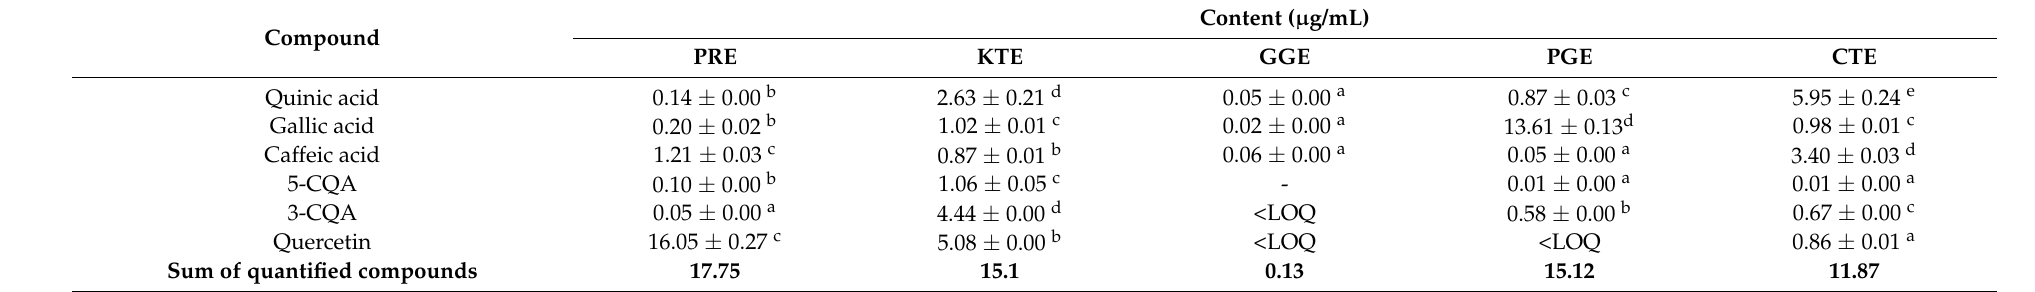
Table 2. Quantification results obtained for PRE, KTE, GGE, PGE and CTE extracts. Values are means ± SD of triplicate experiments. Different letters indicate significant differences between groups ( p <